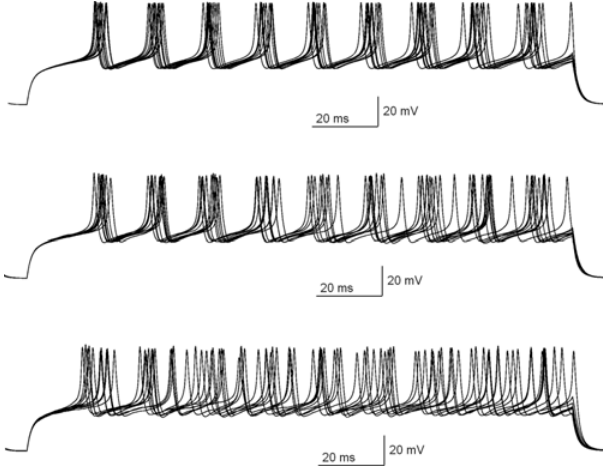
Figure9. Exploringthe variabilityin spike timing. Threesetsof ten realizations of firing are simulated with the stochastic granule cell model using a depolarizing current pulse just above the firing threshold ( I app =12 pA). The length of each trace is 0.1 seconds. In the upper panel s =0.1, in the middle panel s =0.3, and in the lower panel s =0.5. The main variability does not arise only from the timing of the first action potential, but there is significant variability also after the first spike.